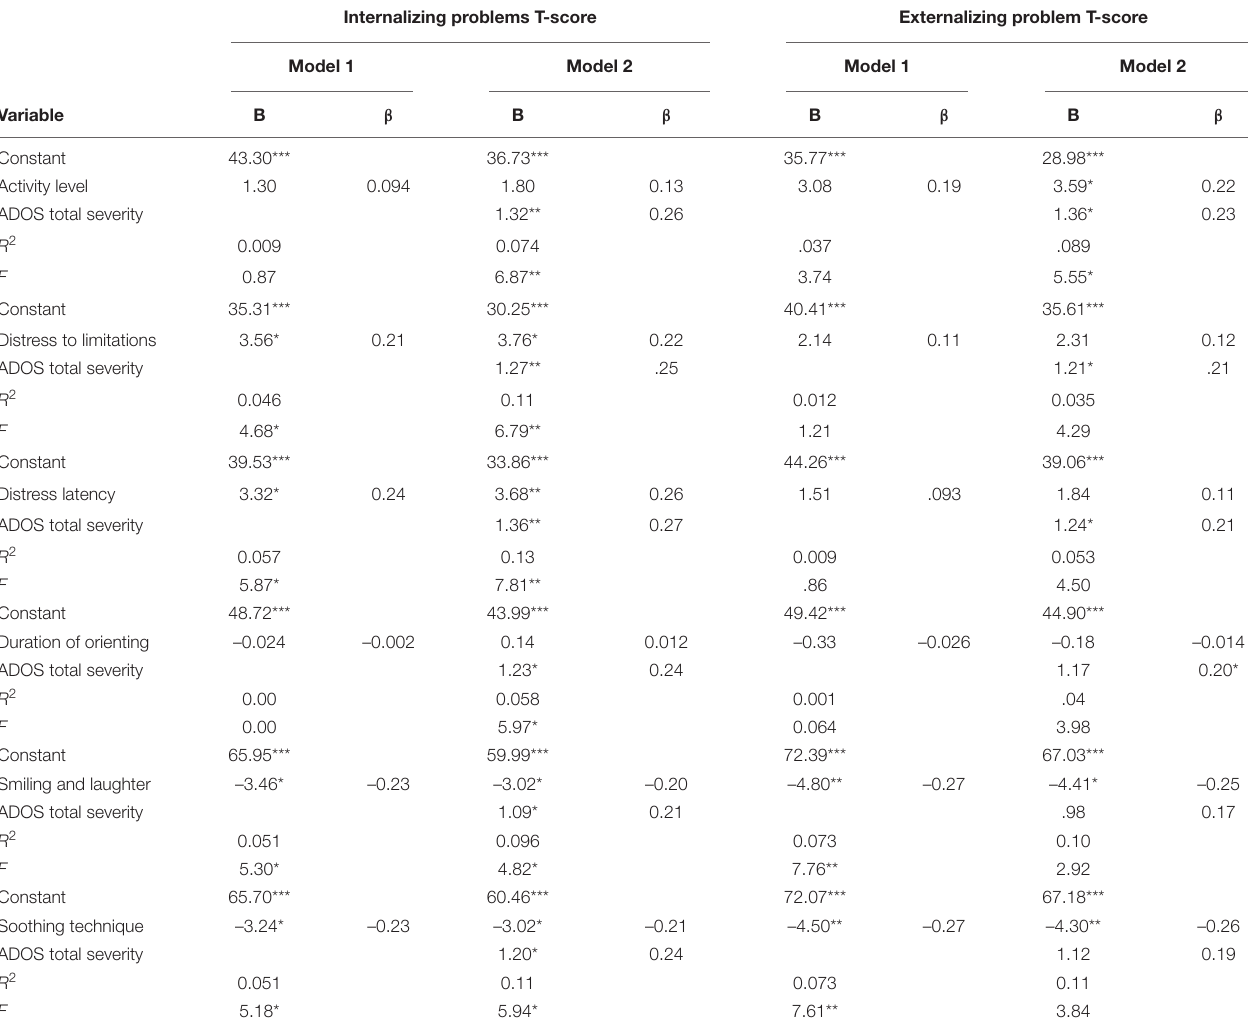
TABLE 3 | Predictive relationships between 5-year internalizing and externalizing problems and 6 month temperament scales. Internalizing problems